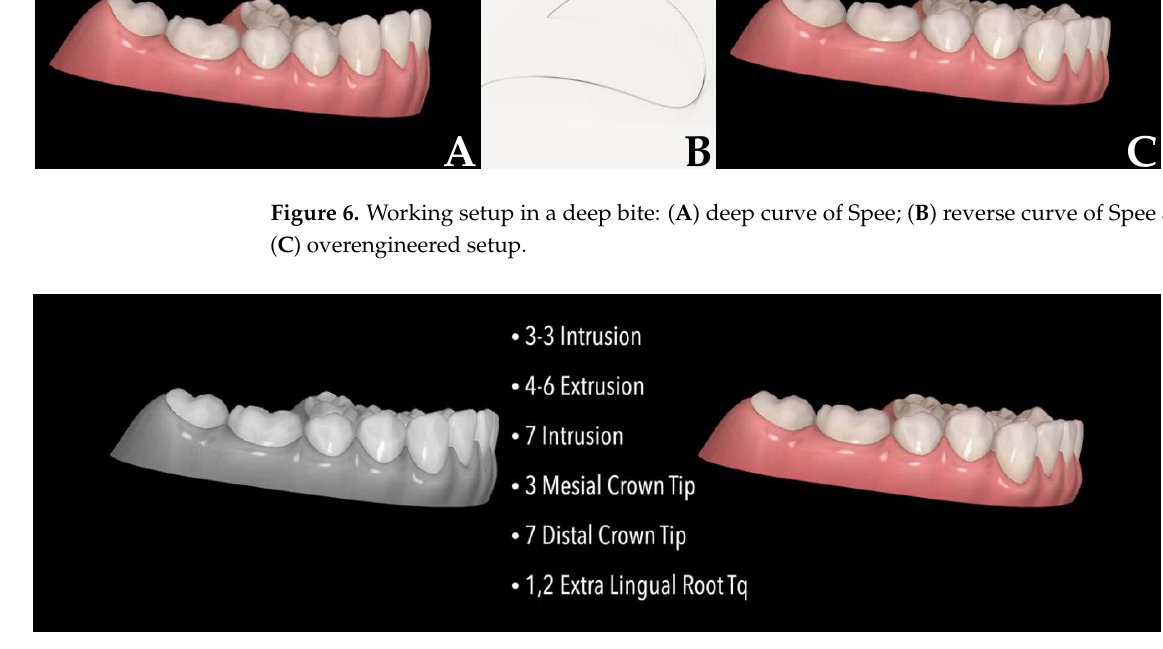
Figure 7. Overcorrection of the digital setup.